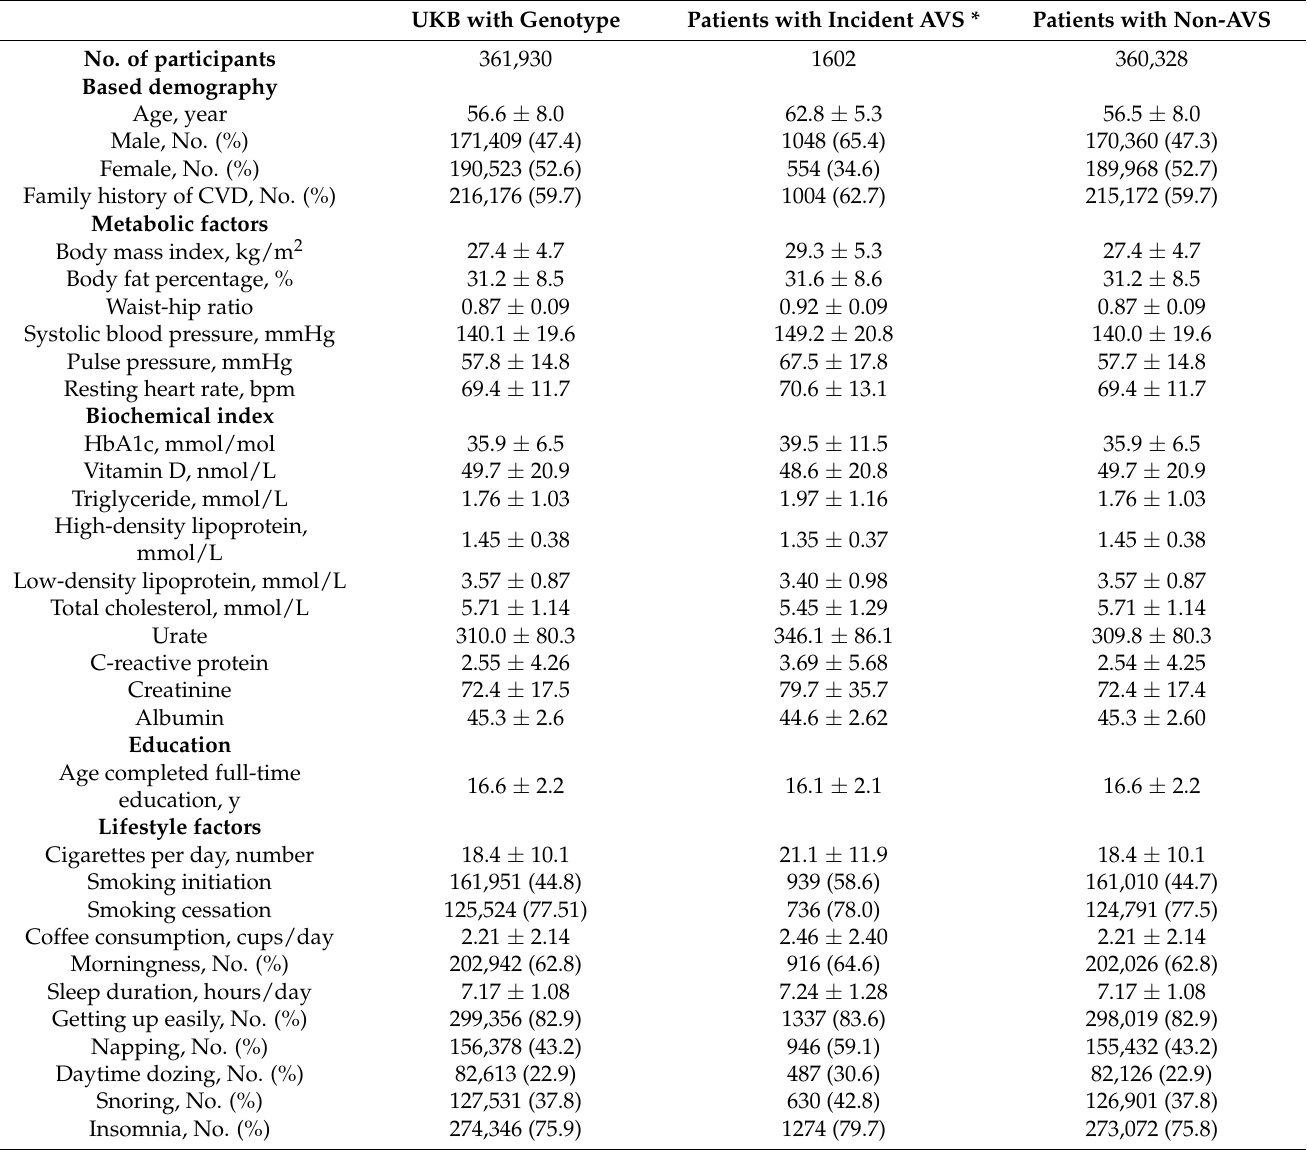
Table 1. Characteristics of the study